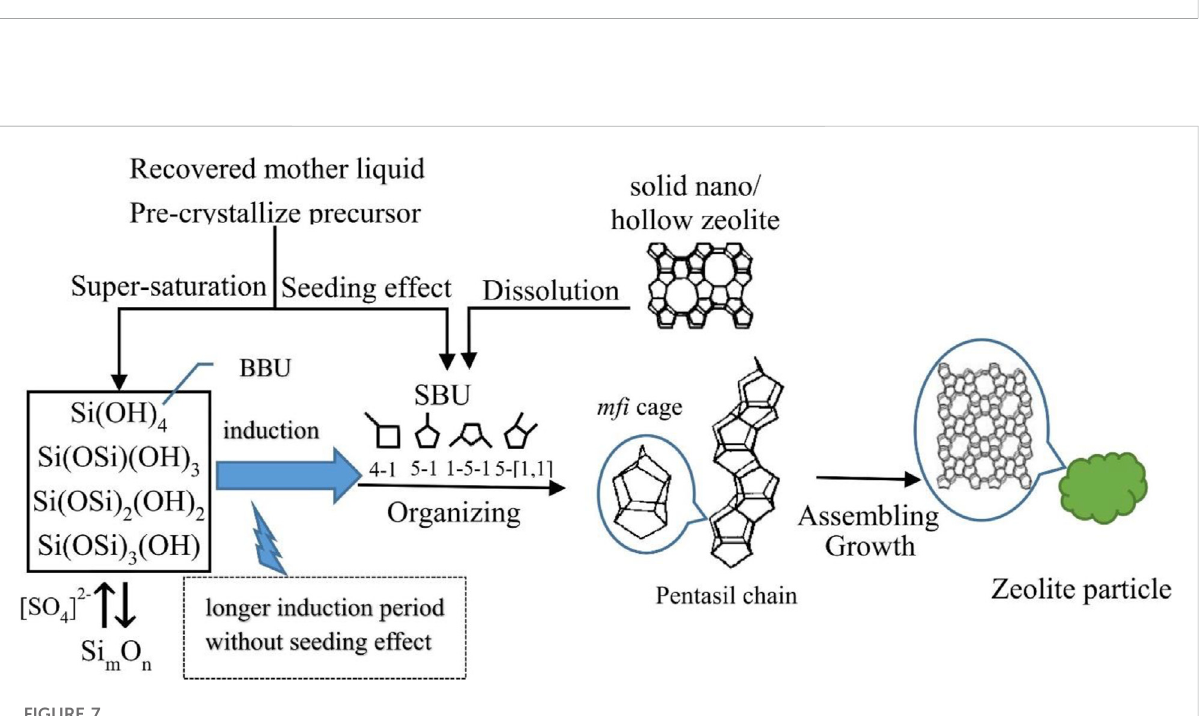
FIGURE 6 TheproposedroutefortheformationofbulkyparticlesformedbyTS-1zeolitenanocrystalsinthepresenceofH 2 O 2 .Reprintedwithpermission from Shan et al. (2010). Copyright 2010 Wiley-VCH.